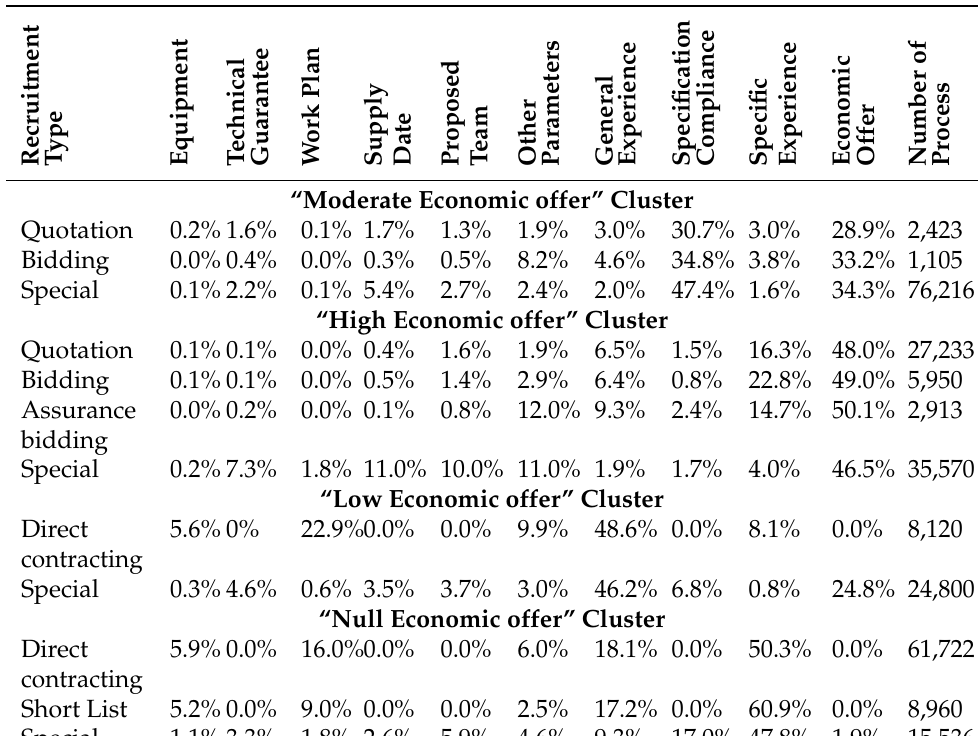
Table 5. Clusters Type of purchase.